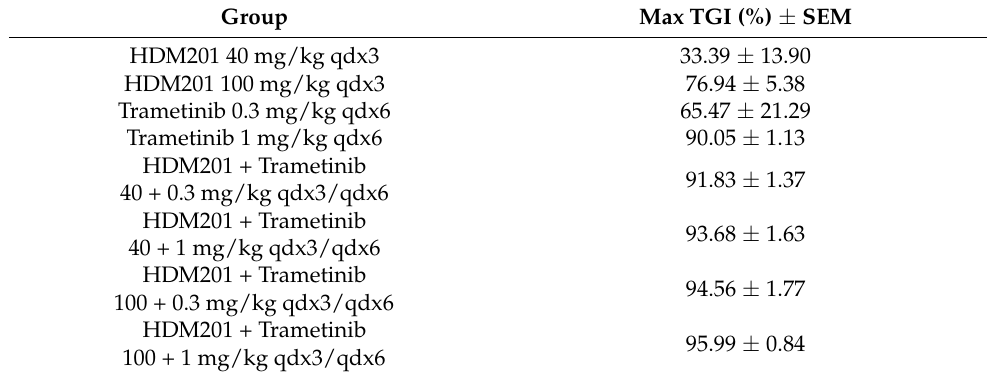
Table 7. Mean tumour growth inhibition (TGI) values with standard error of mean (SEM) as metrics of in vivo efficacy of HDM201, Trametinib, and their combination in A375-inoculated CD-1 nude mice n =